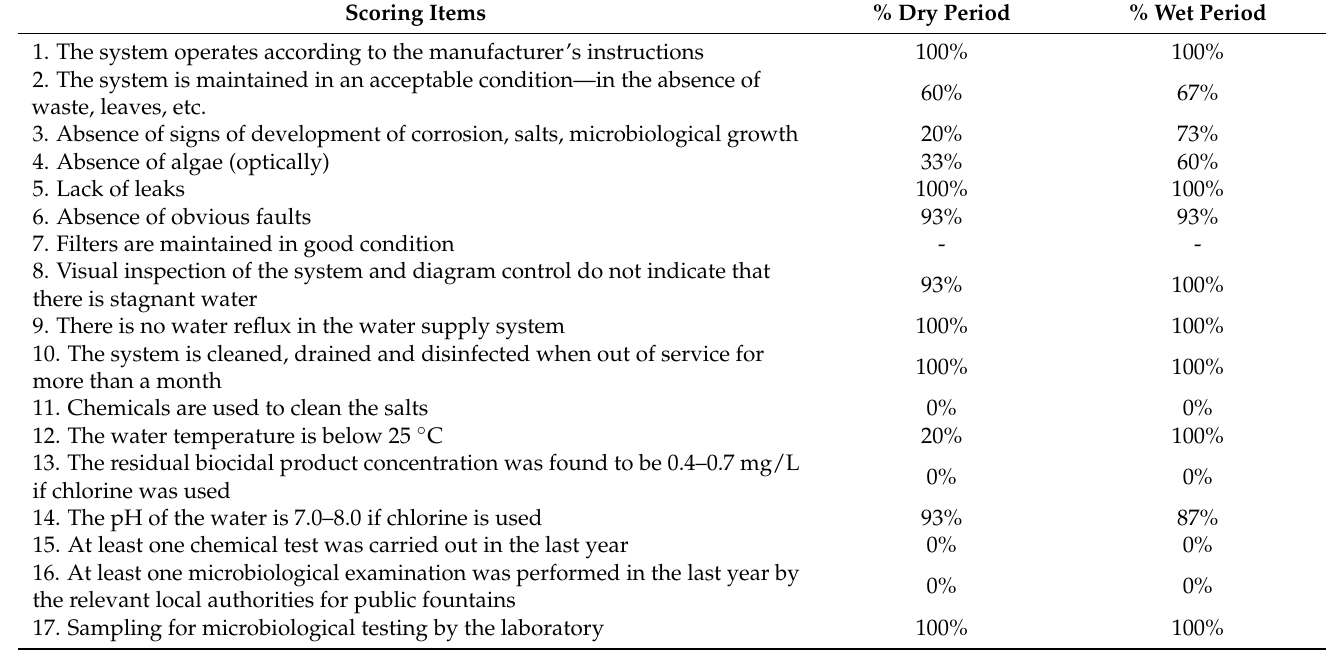
Table 3. The percentages of compliance of the fountains with the question points from the checklist ( n = 15) for the dry and wet periods.